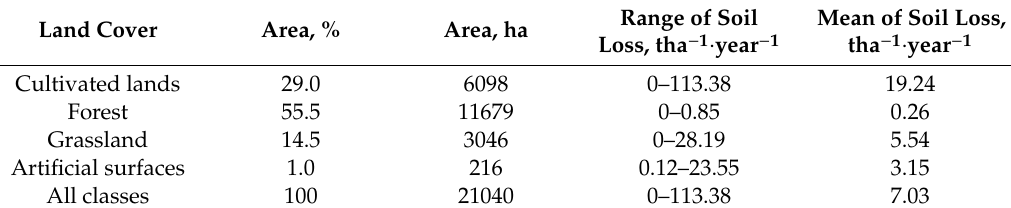
Table 3. Soil loss and land cover classes in the Tarbagataika basin.